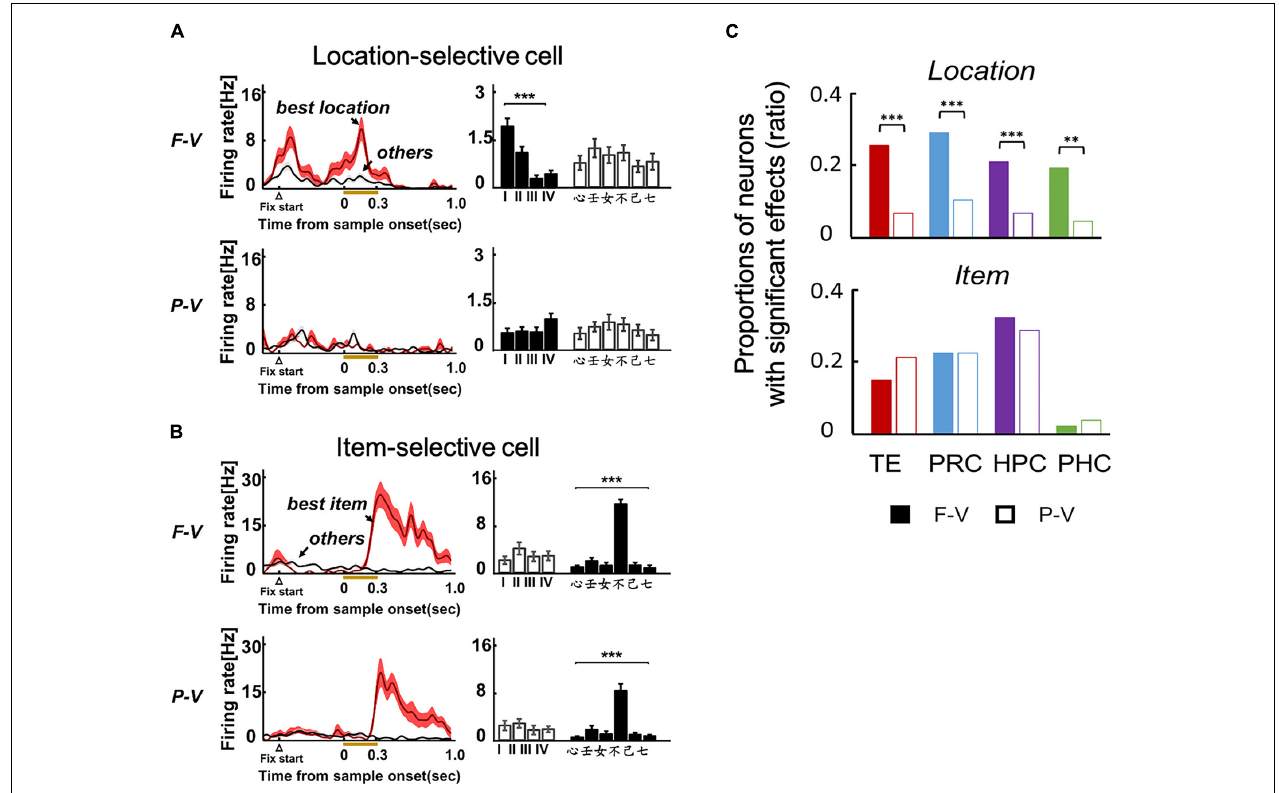
FIGURE 3 | Location and item selective responses in the two viewing conditions of the ILR task. (A) Example of a location-selective cell from TE in the F-V (Top) and P-V (Bottom) conditions of the ILR task. The neuron showed location-selective responses only in the F-V condition. (B) Example of an item-selective cell from TE. The neuron showed the same preferred item between the F-V and P-V conditions. *** P < 0.0001. Two-way ANOVA with interaction for each cell and view condition. (C) Proportions of location-selective cells (Top) and item-selective cells (Bottom) during the sample period in the F-V (Filled bars) and P-V (Open bars) conditions in the ILR task. ** P = 0.0011, X 2 = 13.24, d.f. = 1 for PHC. *** P < 0.0001, X 2 = 20.67, 20.01, and 30.82 for TE, PRC, and HPC, respectively. P values were corrected by Bonferroni corrections among the four recording regions. Adapted with permission from Chen and Naya